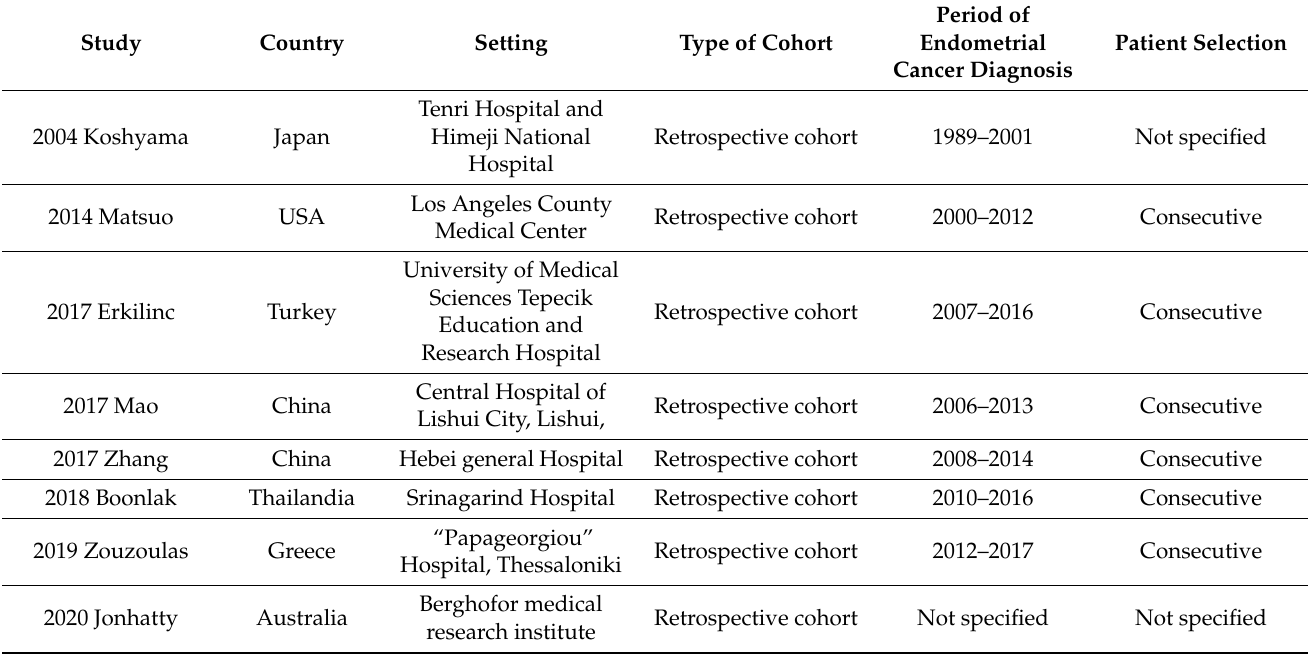
Table 1. Characteristics of the included studies.